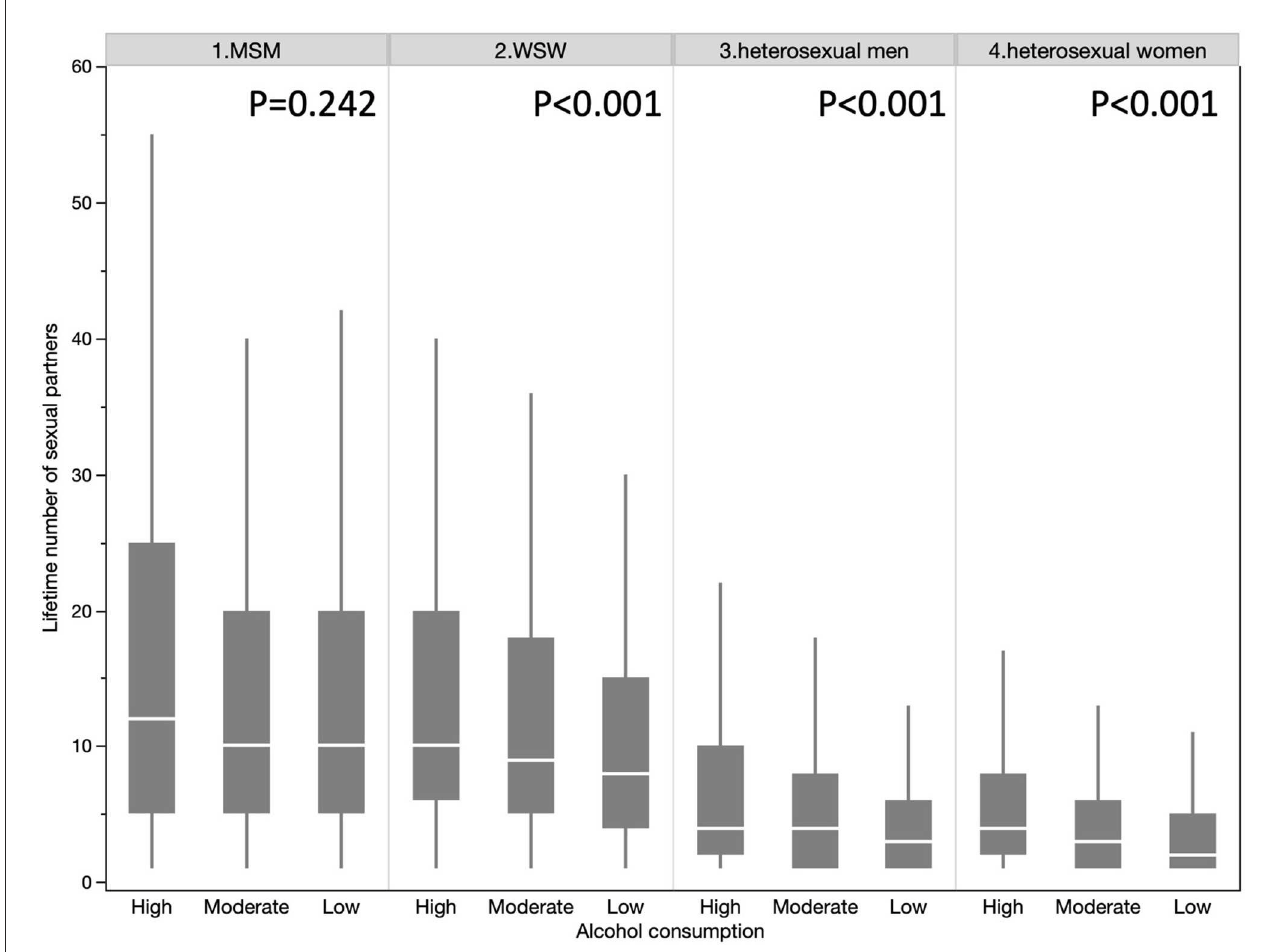
FIGURE4 Lifetime number of sexual partners in each groups according to alcohol consumption